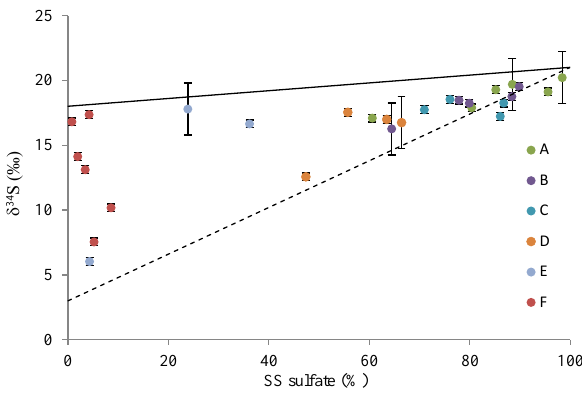
Figure 4. Total δ 34 S versus the percentage of sea salt sulfate of size-fractionated aerosols. The mixing lines show sea salt–biogenic sulfate (solid line) and sea salt–anthropogenic sulfate (dashed line) contributions. The standard deviations of each run were taken as the uncertainty for δ 34 S